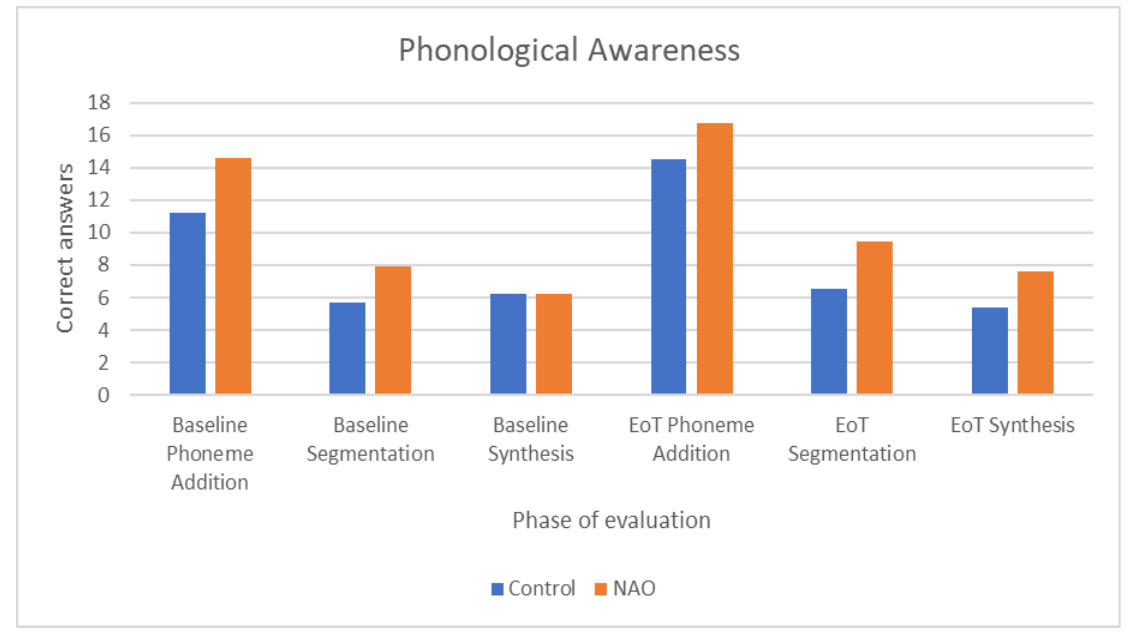
Figure 2. Correct answers in phonological awareness tasks between baseline and end of treatment (EoT) by group.